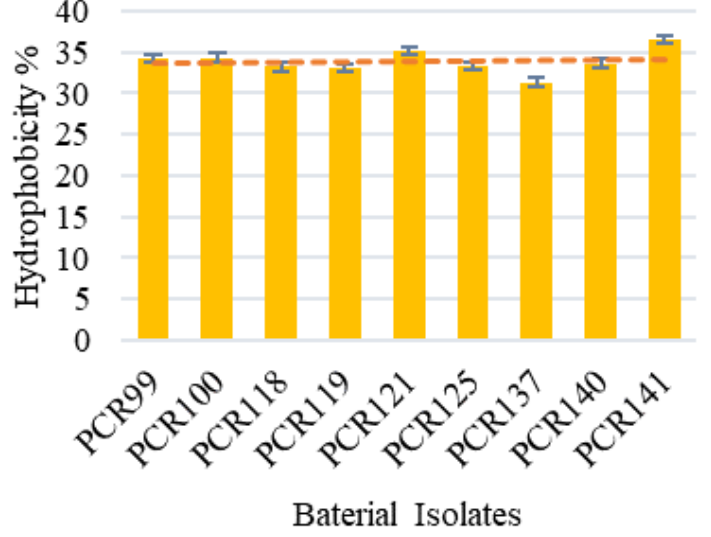
Figure 4. Determination of Hydrophobicity % of bacterial isolates. Values are means of replicate experiments; ± indicates standard deviation from the mean. Values differs significantly ( p < 0.05).